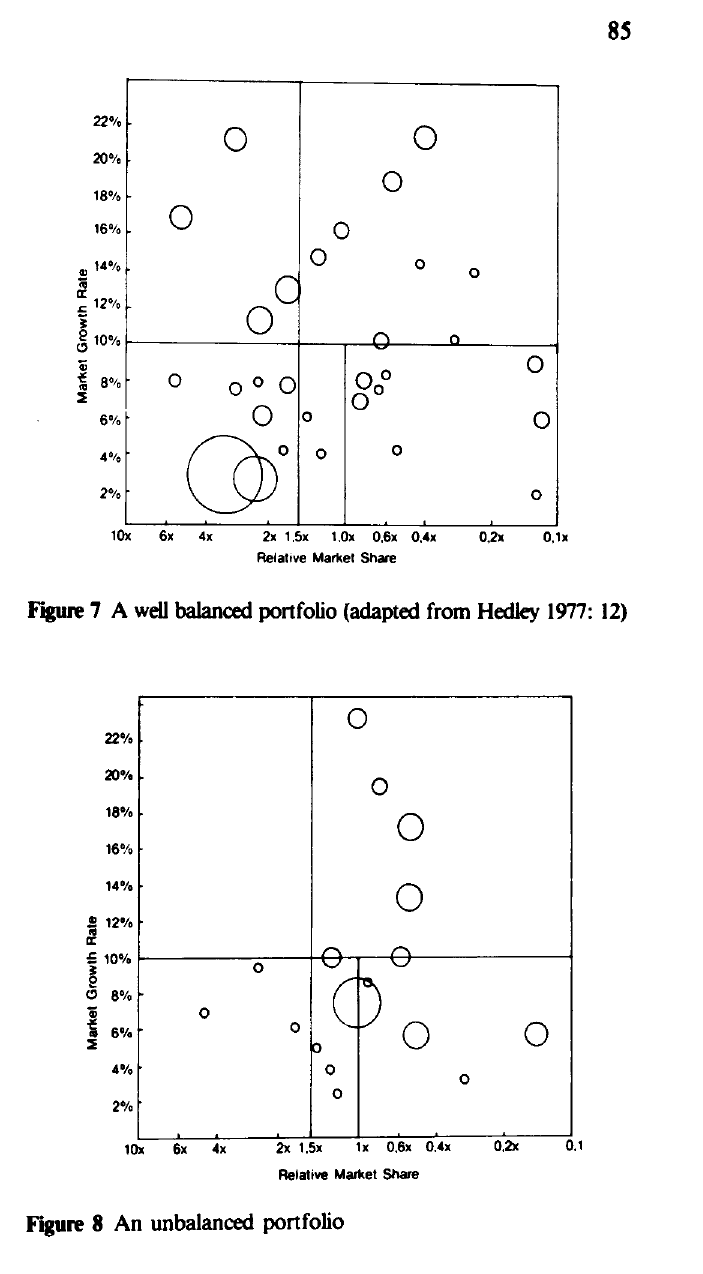
Figure 8 An unbalanced